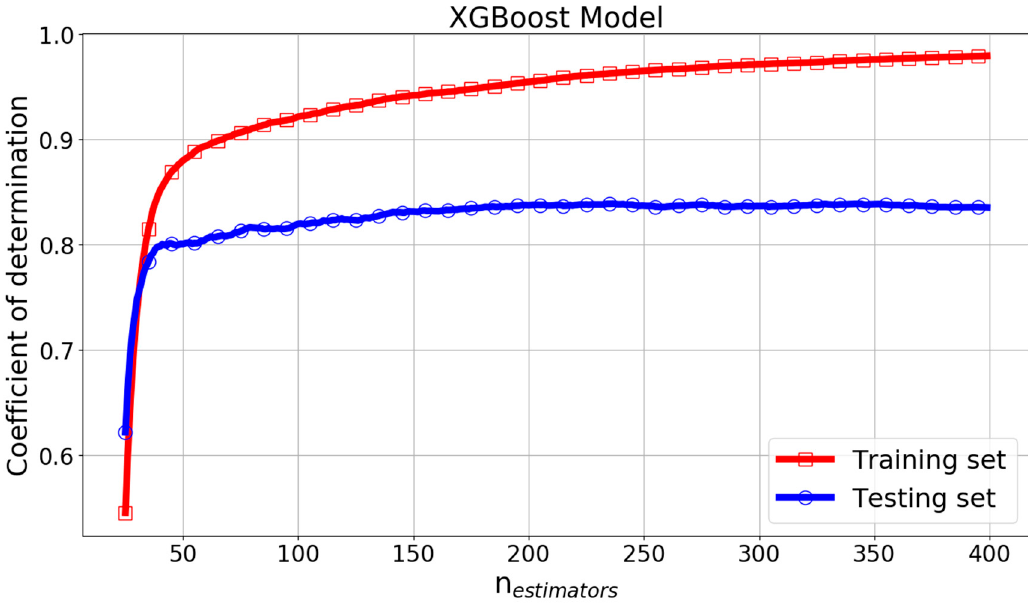
Figure 24. R 2 change curve of XGBoost model with parameter n estimators.